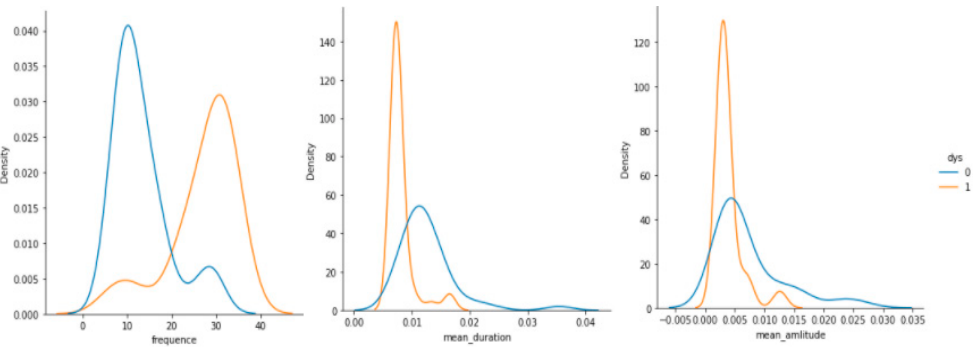
Figure A11. Distribution of the DGI for the painting seven dataset.